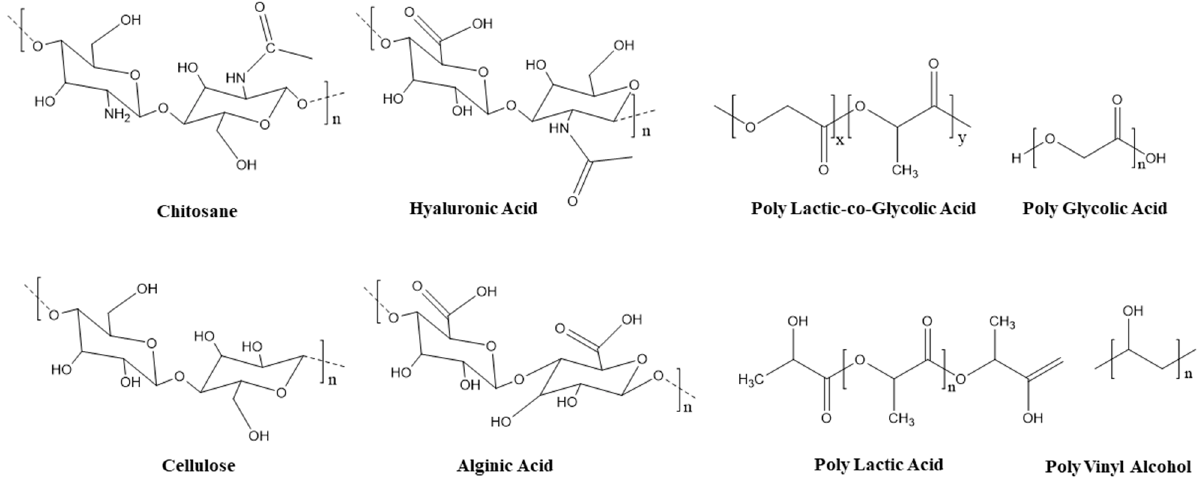
Figure 5. Polymeric scaffolds used in bionanomaterials applications. Natural polymers (chitosan, hyaluronic acid, cellulose and alginic acid) and synthetic polymers (poly lactic-co-glycolic acid, poly glycolic acid, poly lactic acid and poly vinyl alcohol) [32]. Both types of polymers are hydrophilic and absorb excess of wound exudates [73].